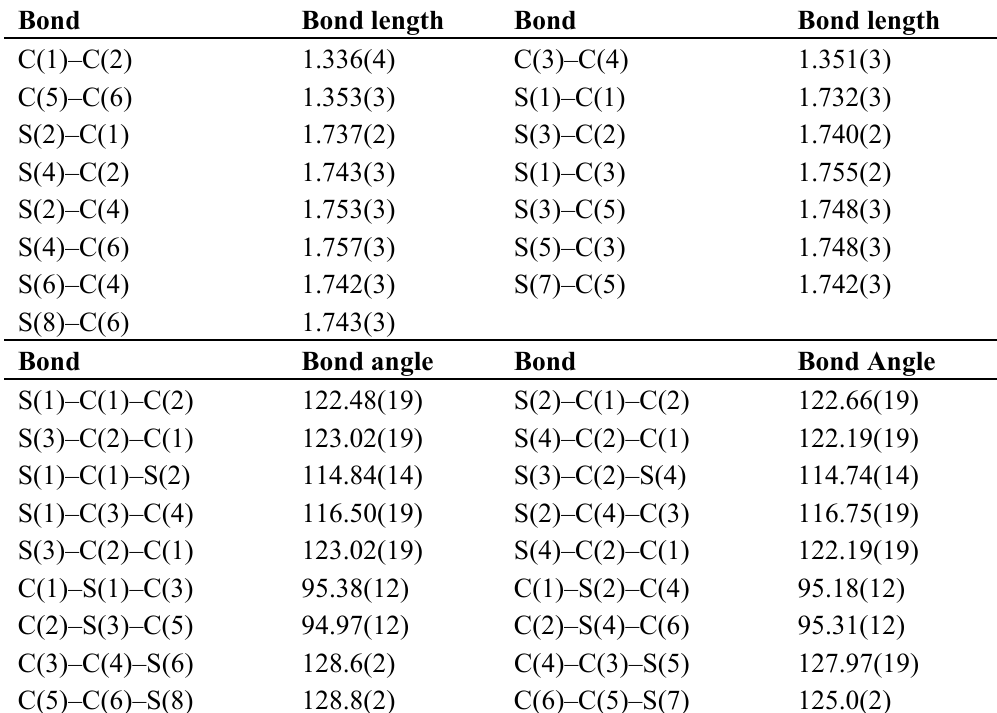
Table 2. Selected bond lengths (Å) and angles (°) of donor moiety of 1